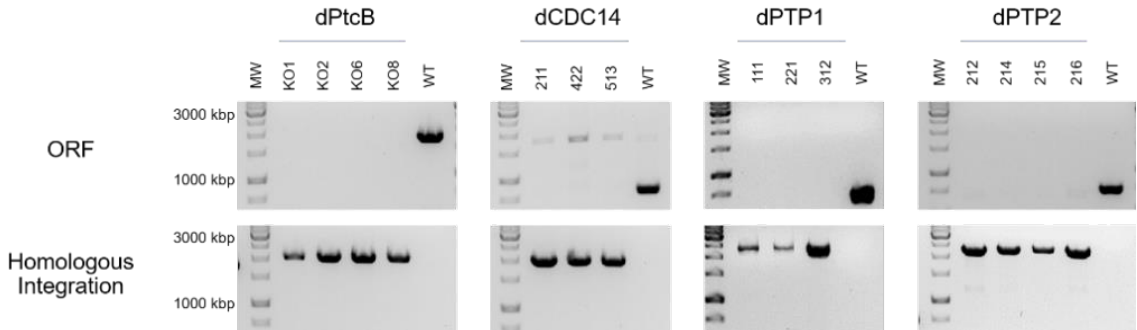
Figure 2. PCR verification of the gene replacement. ORF: amplification of an internal part of the ORF of each gene was performed using primers ORF-FR and ORF-RV. Homologous Integration: a 5′ region of the integrated HYG gene with the upstream flank was amplified, using primers HI–Upstream and NLC37 (Table 1) for the indication of the HYG gene insertion. The numbers indicate independent transformants.